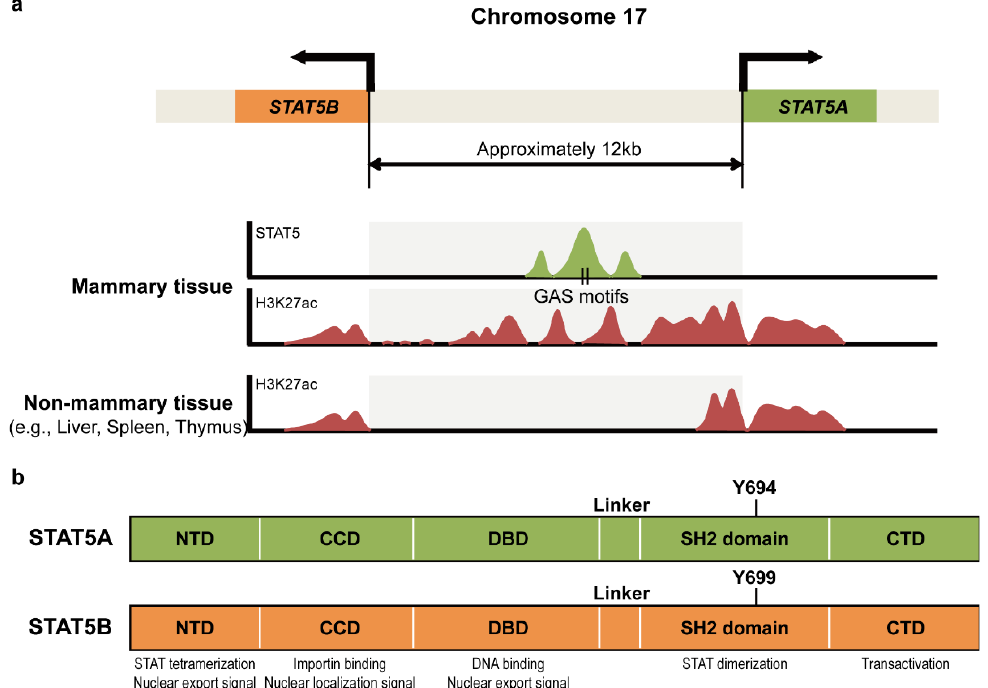
Figure 1. Schematic diagrams of the STAT5 genomic locus and its functional domains. ( a ) Genomic location of genes encoding STAT5A and STAT5B. The transcription start sites of STAT5A and STAT5B are oriented in opposite directions within a ~12 kb sequence on human chromosome 17. ChIP-seq analyses revealed that the STAT5-bound enhancer is only found in the intergenic region between the STAT5A and STAT5B genes in mammary tissue and is essential for autoregulation of STAT5 transcription. ( b ) Functional domains of STAT5A and STAT5B. The NTD is required for STAT5 tetramerization and contains a Crm1 exportin-mediated nuclear export signal. The CCD contains a nuclear localization signal and binds to importin proteins. The DBD binds to the STAT5 binding motif of the target promoter and contains a Crm1-independent nuclear export signal. The SH2 domain is important for STAT5 homo- or heterodimerization and the CTD functions in transactivation. Phosphorylation of a specific tyrosine residue (Y694 of STAT5A and Y699 of STAT5B) is essential